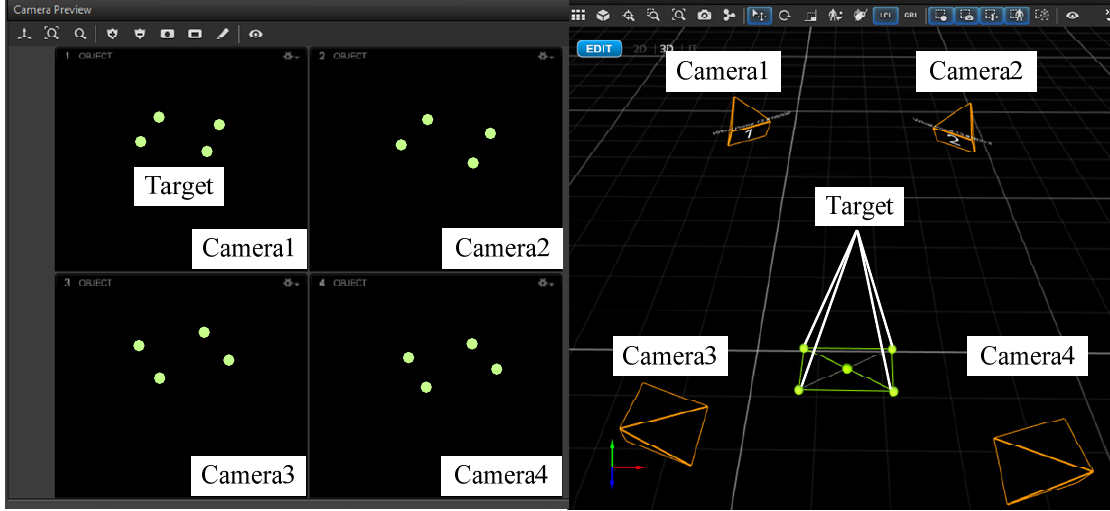
Figure 27. Target image and the positions of four camera in the space payload ground capture test system.